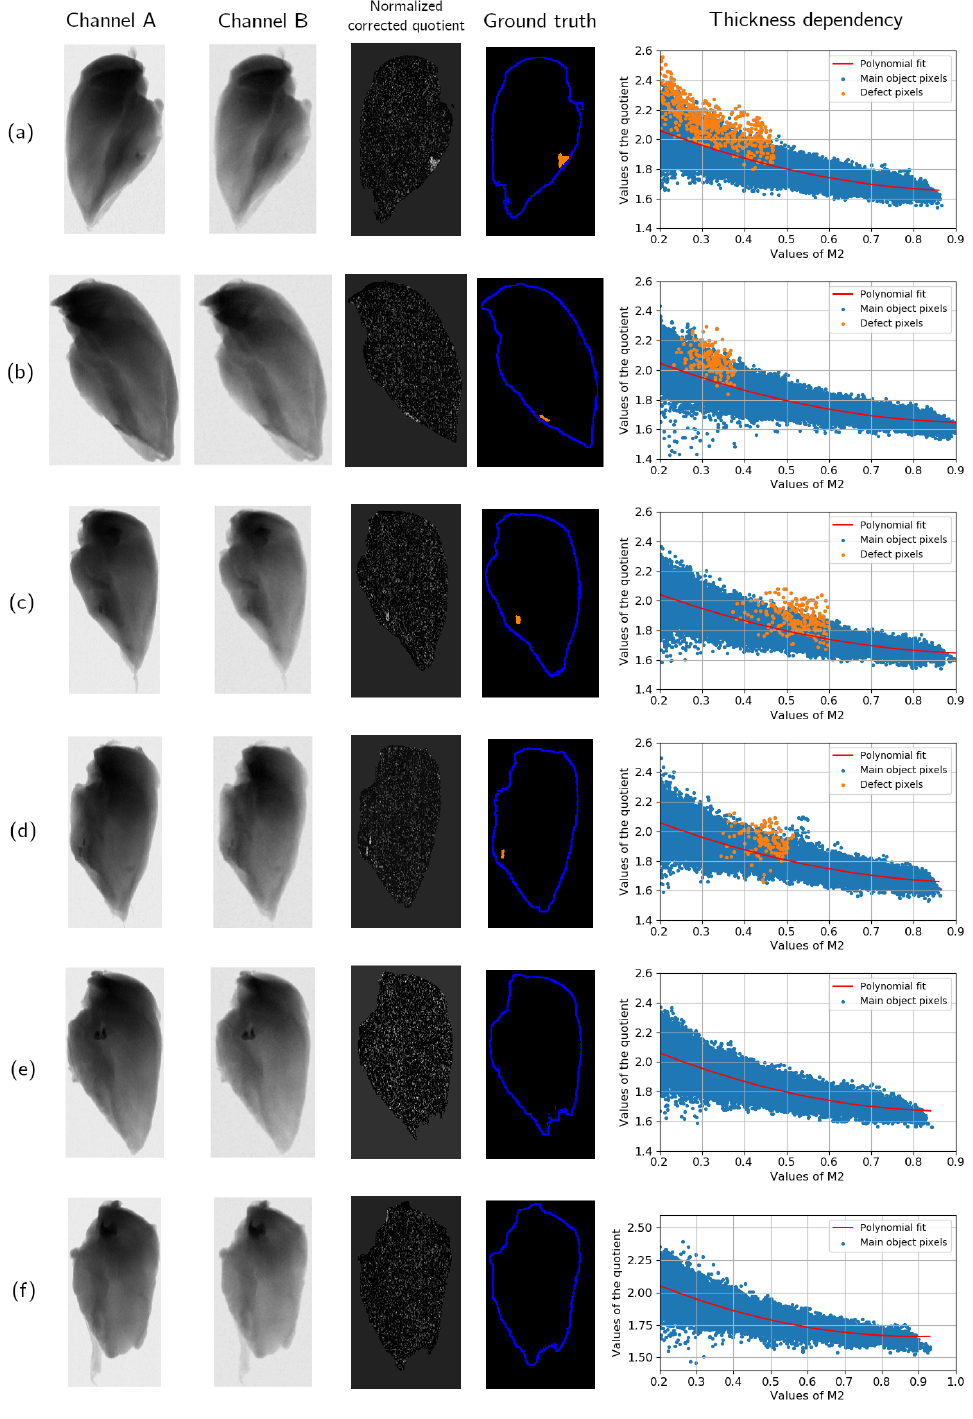
Figure 7. Different samples from the experimental dataset. For every object, two projections acquired with different voltages, the N ( x ) distribution, the segmented image, and the thickness dependency plot are shown. Sample ( a ) contains a fan bone, sample ( b ) has a large rib bone, cases ( c , d ) show small rib bones, and samples ( e , f ) do not contain defects. The boundaries of the samples are approximately drawn as blue curves, but they are not used during the inspection procedure. The defect location is marked in orange and corresponds to the ground truth images from the dataset. Ground truth in sample ( d ) is partially wrong and does not include the second part of the shattered